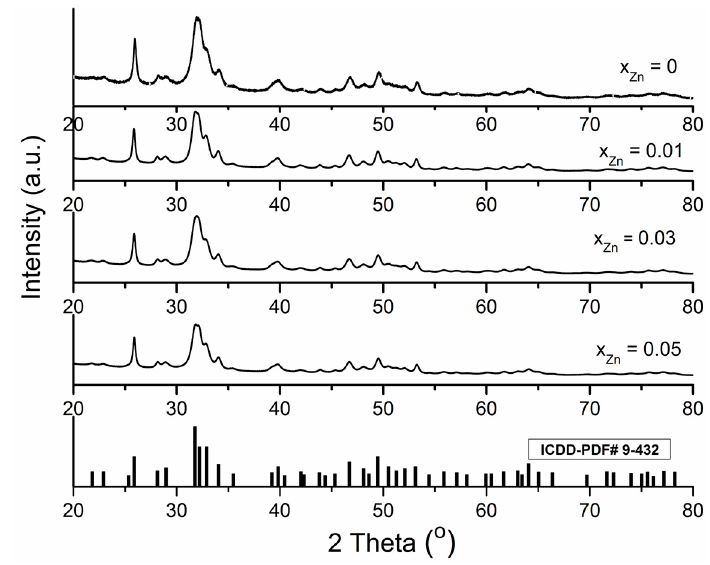
Figure 1. The XRD (X-ray diffraction) patterns of HAp and Zn:HAp, Ca 10 − x Zn x (PO 4 ) 6 (OH) 2 synthesized samples with 0 ≤ x Zn ≤ 0.05.